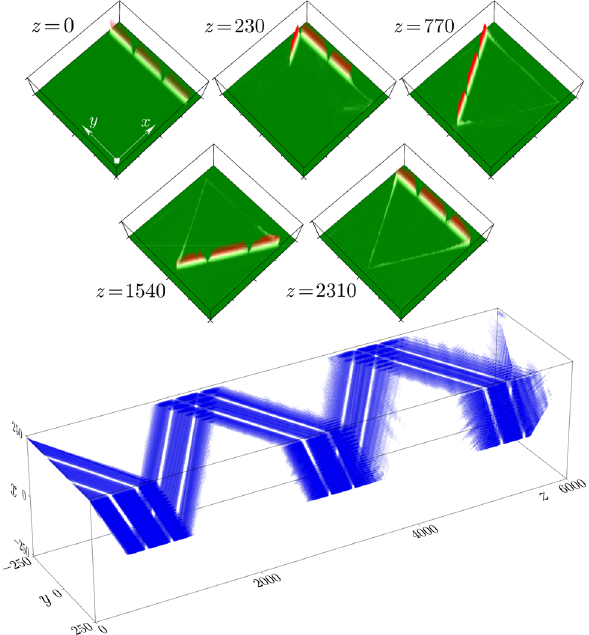
Figure5: Topologicalprotectionof thedarkvalleyHalledgesoliton. Isosurface intensity plot illustrating propagation of the dark valley Hall edge soliton along triangular domain wall, with the two white stripes corresponding to dark solitons. Field modulus distributions at different distances are also shown in the top five panels. Solitons corresponds to k y = − 0.3K and b nl =